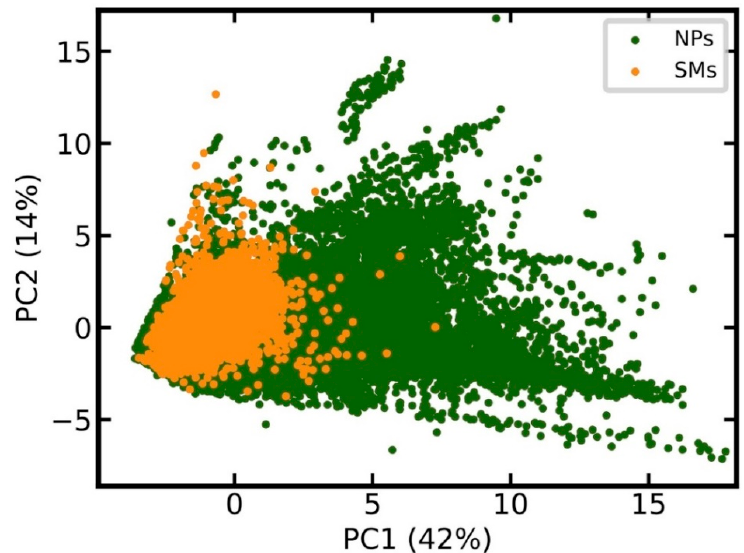
Figure 1. Comparison of the chemical space covered by natural products (NPs) and synthetic organic molecules (SMs). The score plot is based on the principle component analysis (PCA) of all molecules in the data set, characterized by 15 calculated physicochemical properties. PCA was performed on the full data sets. For the sake of clarity, only a randomly selected 10% of all data points are reported in the score plot. The percentage of the total variance explained by the first two principal components is reported in the respective axis labels.